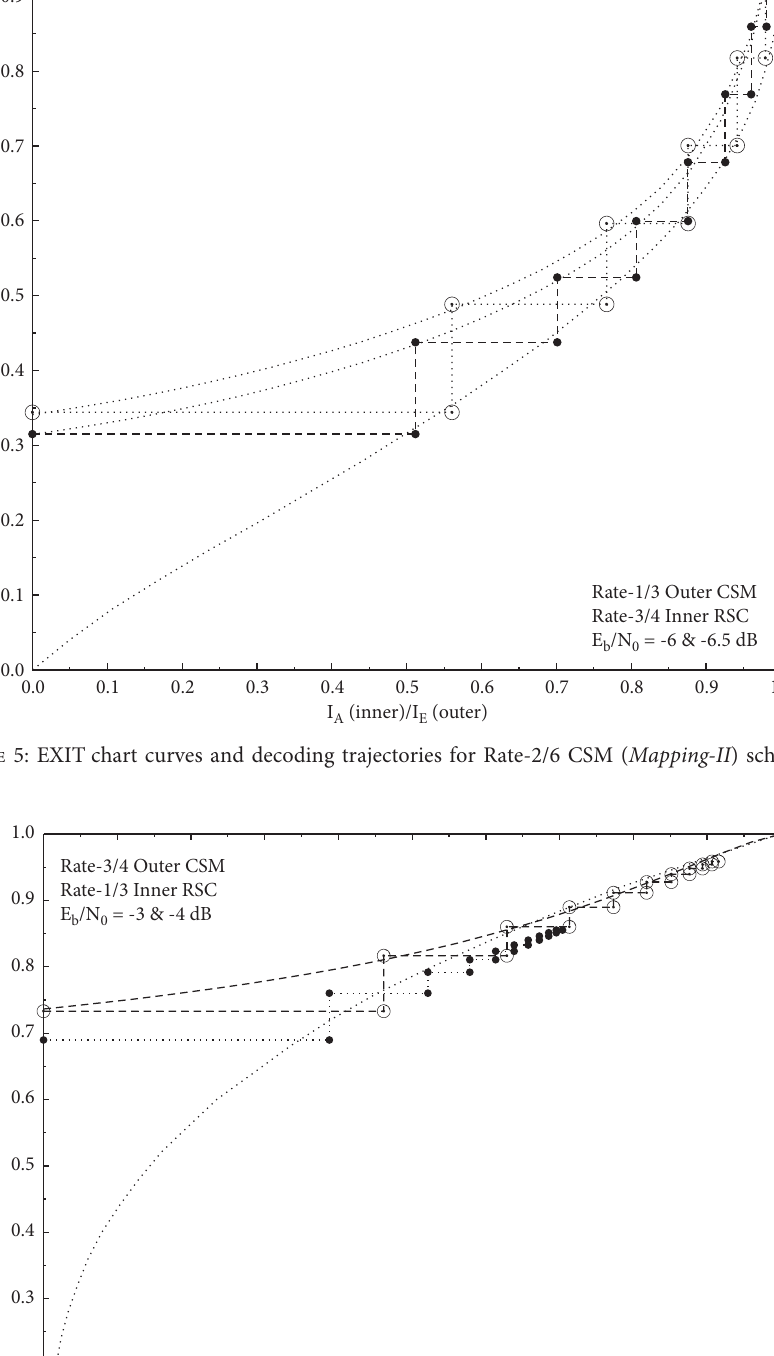
Figure 6: EXIT chart curves and decoding trajectories for Rate-3/4 CSM ( Mapping-I )